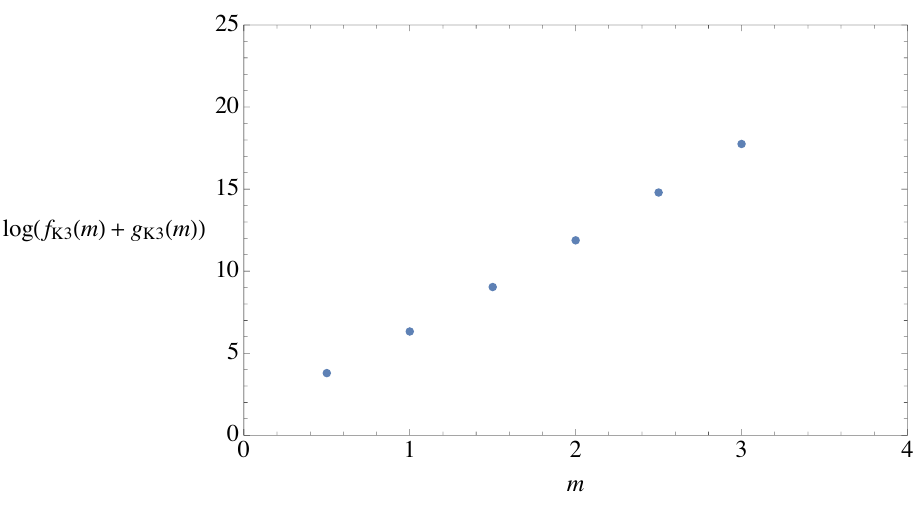
Figure 2 . A plot of log ( f K 3 ( m ) + g K 3 ( m )) up to m = 3 for a generic K 3. Note the exponential growth in m